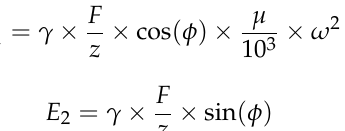
Figure 2. The principle of loading the complex modulus of trapezoidal beam in two-point bending. During the test, the real and imaginary parts of the complex modulus of the asphalt mixture were calculated according to Equations (4) and